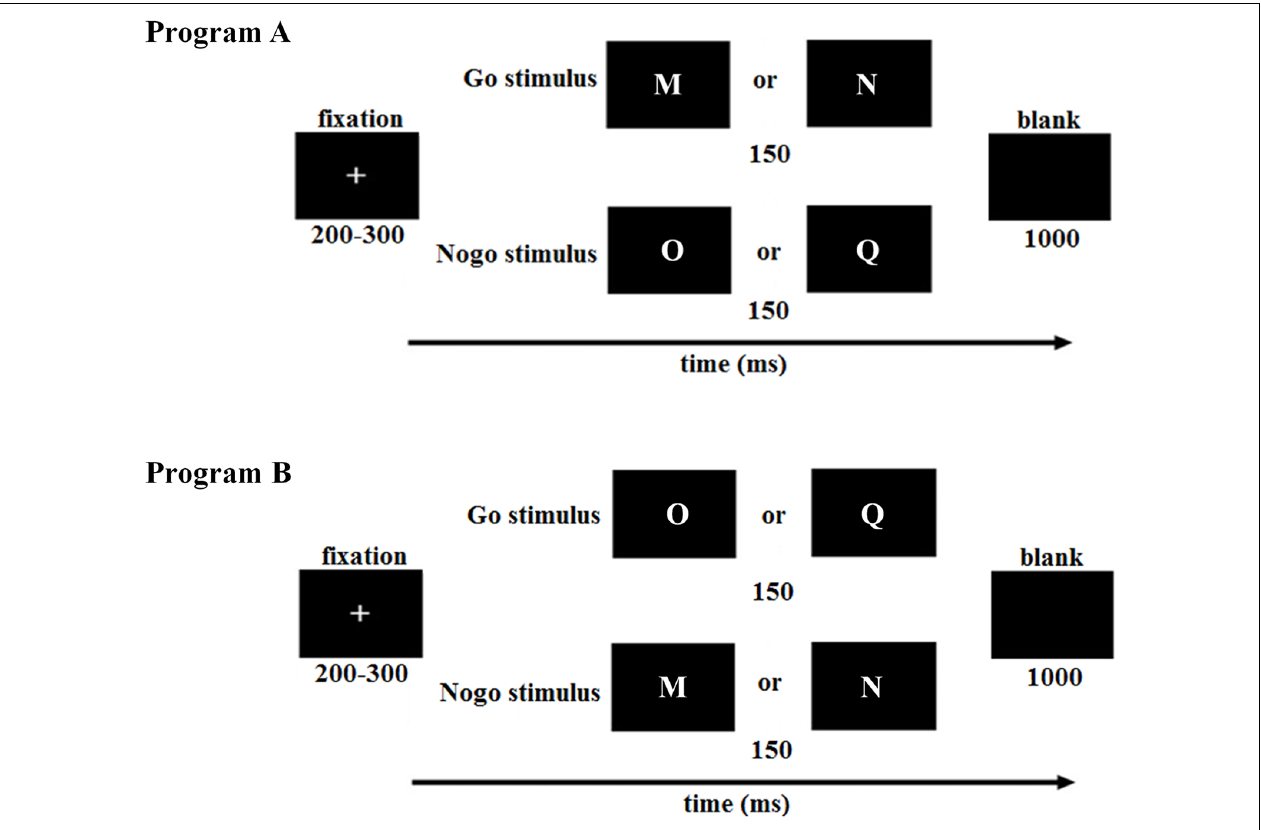
FIGURE 1 | Illustration of the Go/NoGo paradigm in this study. To counterbalance the Go and NoGo stimuli across subjects, the first half of low trait anxiety (LTA) and high trait anxiety (HTA) subjects was assigned to program (A) , while the second half was assigned to program (B) . LTA, the low-trait anxiety group; HTA, the high-trait anxiety